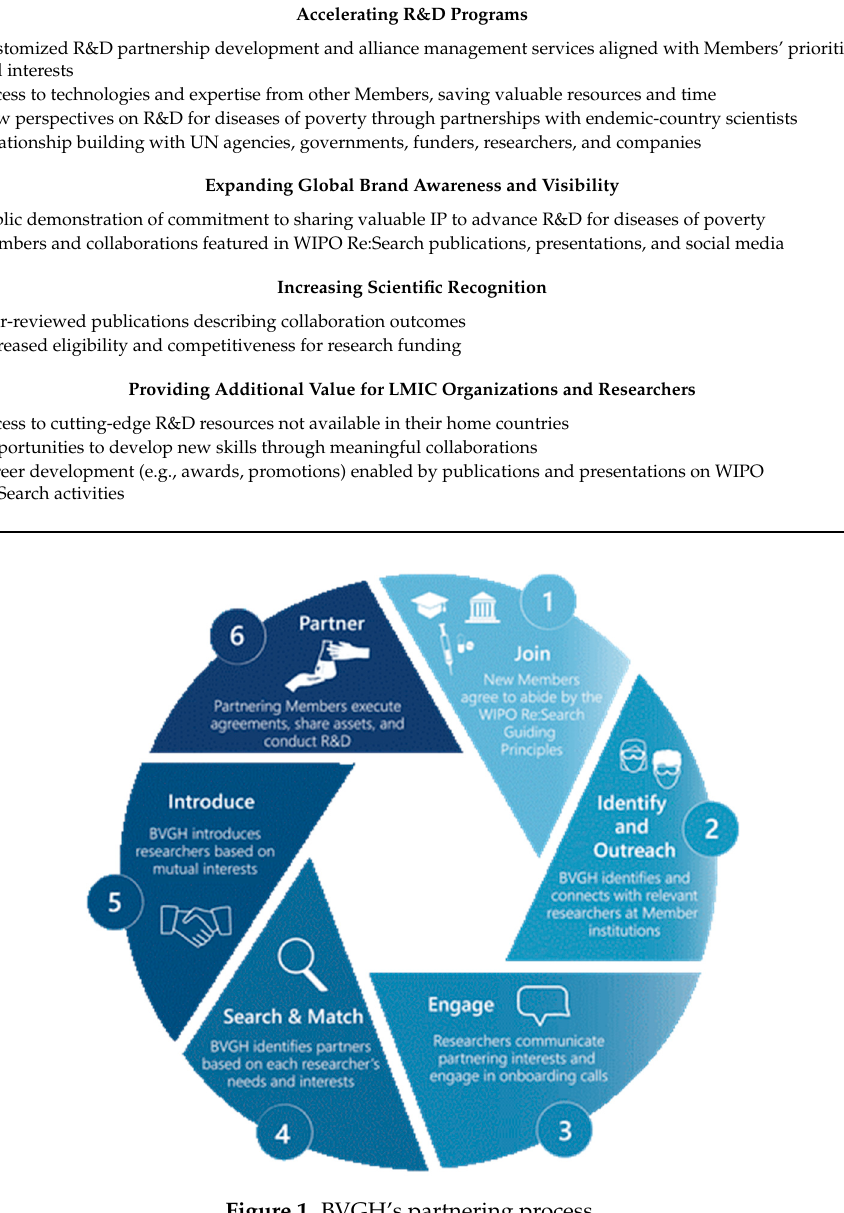
Figure 1. BVGH’s partnering process.